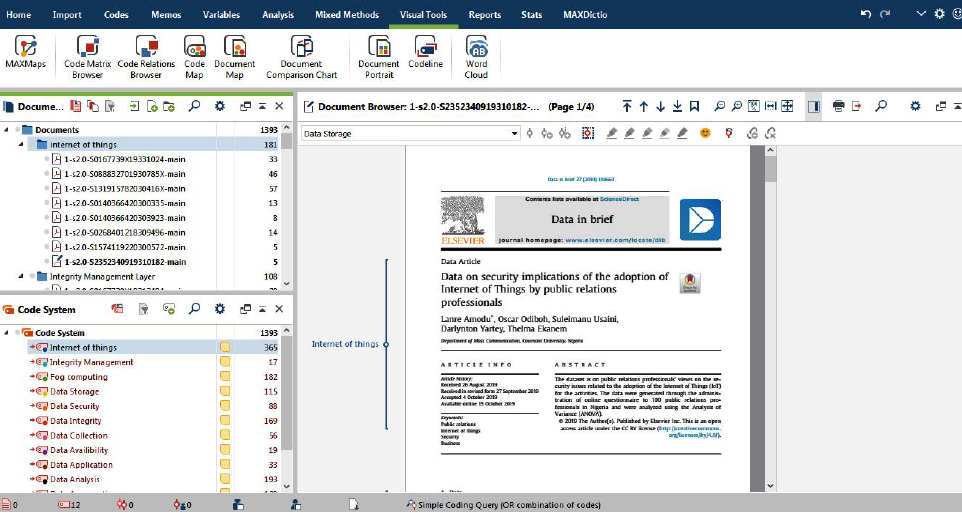
Figure 4. Data File in